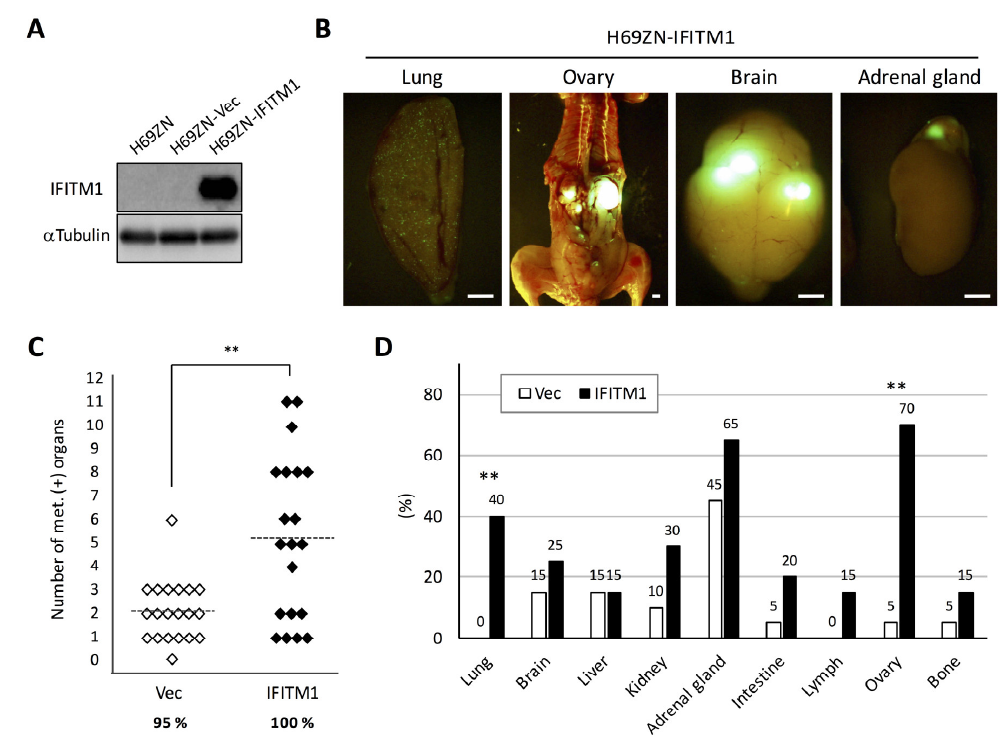
Figure 6. E ff ect of IFITM1 overexpression on the metastatic formation of NCI-H69 cells in nude mice. ( A ) Western blotting of IFITM1 expression in H69ZN cells. Whole-cell lysates (20 µ g) were